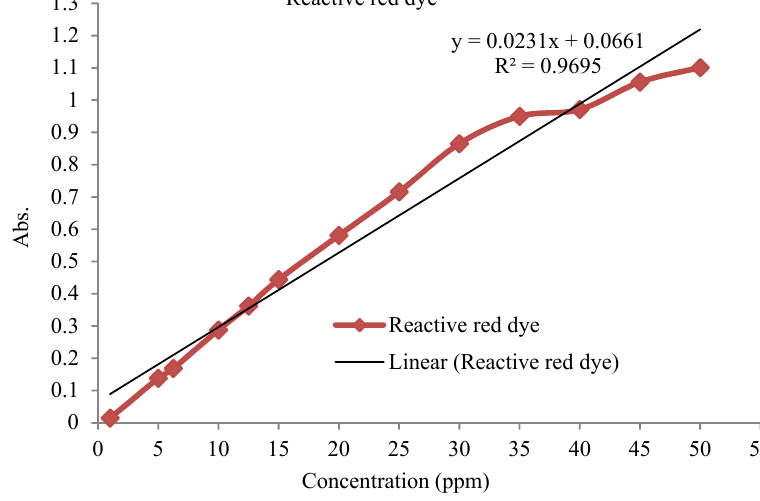
Fig. 2: Standard curve of reactive red dye